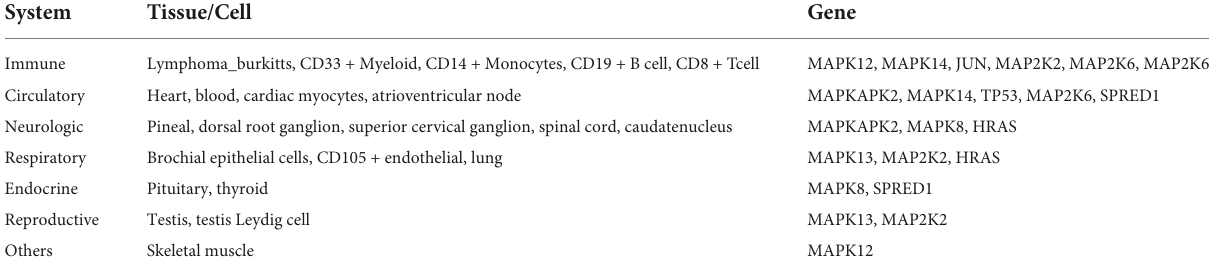
TABLE 1 The most related tissues identified by BioGPS.